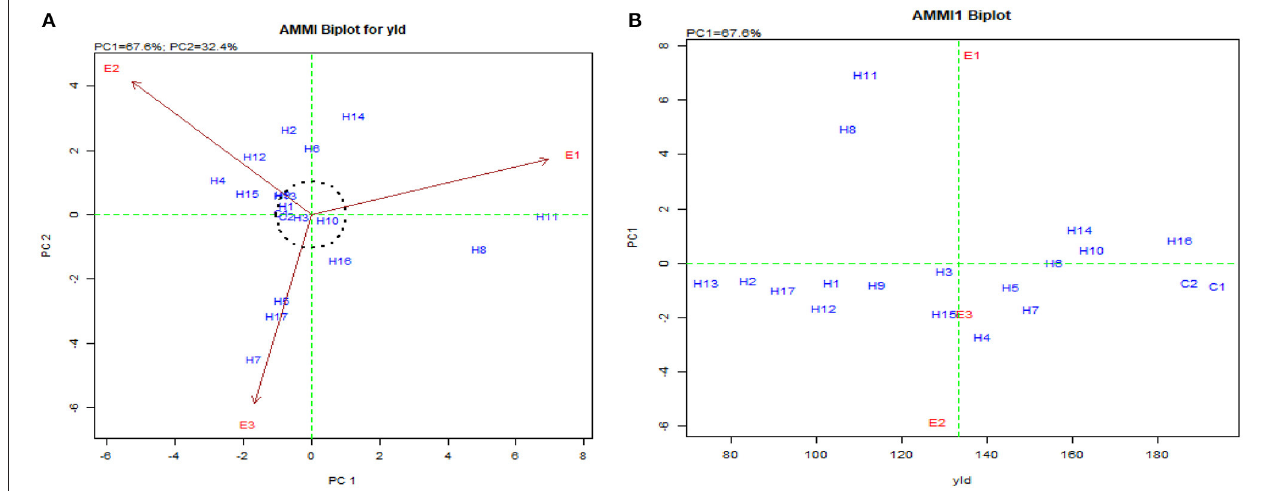
FIGURE 8 | AMMI biplot for single plant yield in the hybrids. (A) AMMI biplot PC1 vs. PC2 for single plant yield and (B) AMMI biplot for the mean of single plant yield (yld) vs. PC1.